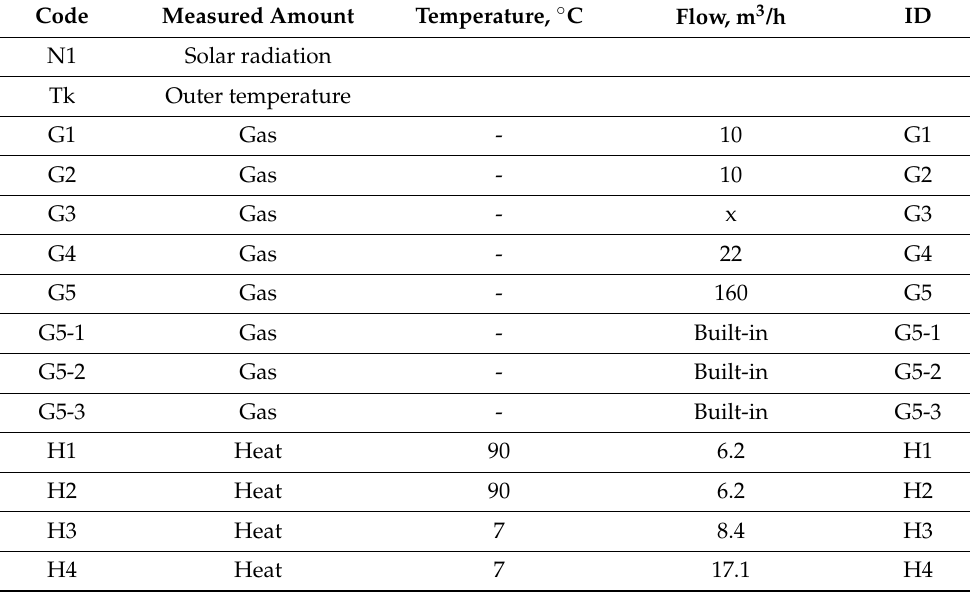
Table 3. Types and characteristics of meters to be